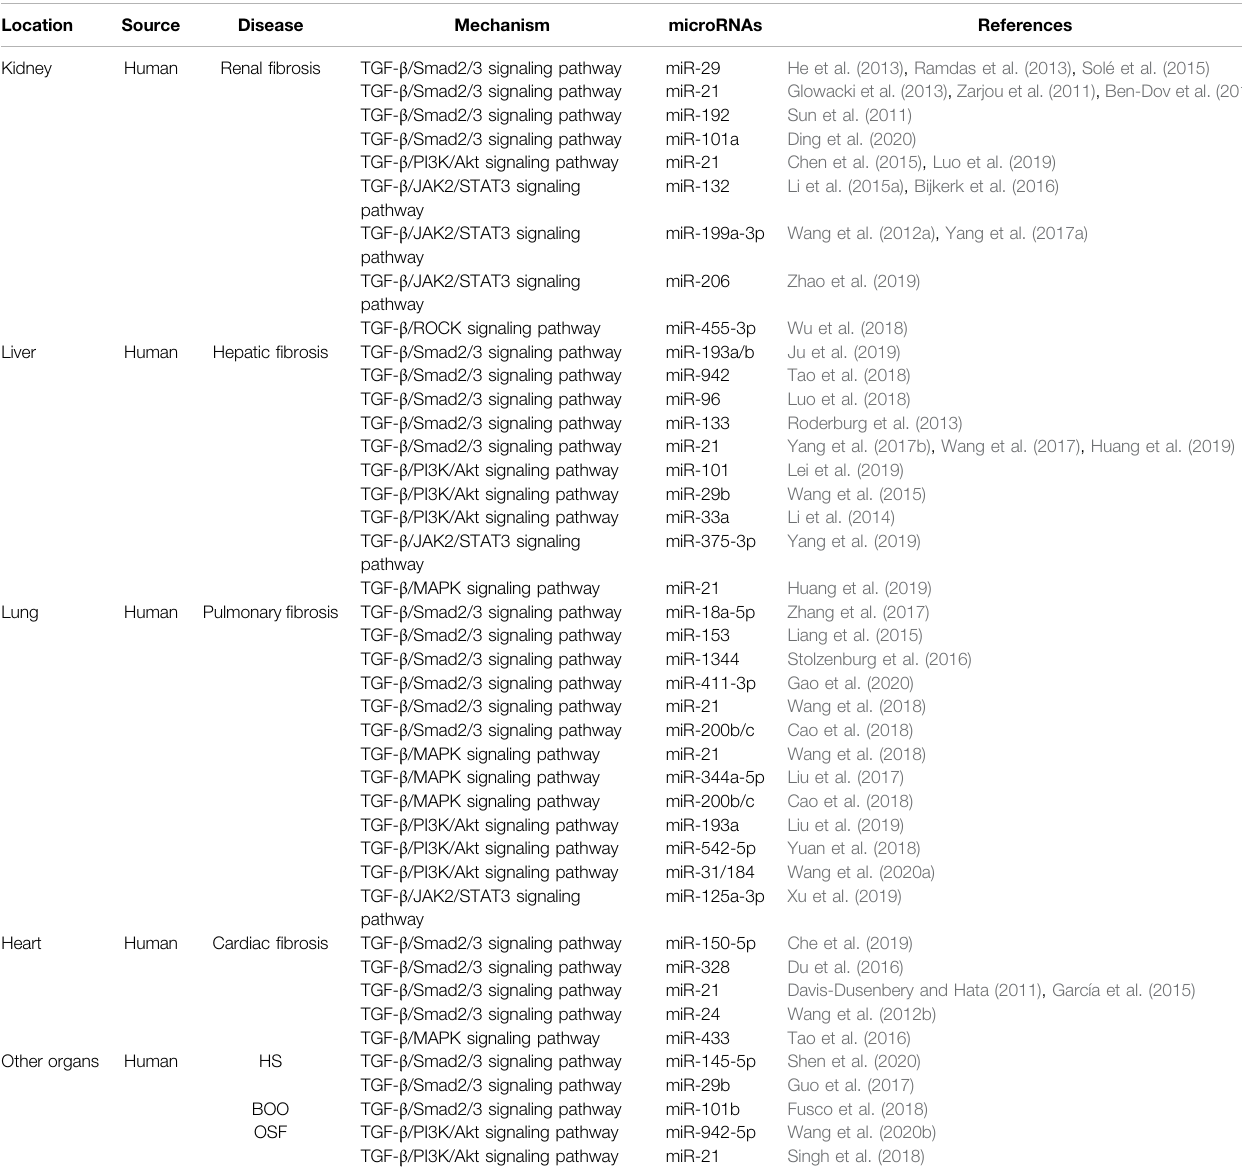
TABLE 1 | MiRNAs in canonical and noncanonicalTGF- β signaling in fi brotic diseases ofdifferent organs. HS, hypertrophic scar; BOO, bladder outlet obstruction;OSF, oral submucous fi brosis;TGF- β , transforminggrowth factor- β ;Smad2/3, drosophila mothers against decapentaplegic protein 2/3; PI3K, phosphatidylinositol 3-kinase; Akt, protein kinase B; MAPK, mitogen-activated protein kinase; JAK2, Janus kinase 2; STAT3, signal transducer and activator of transcription 3; ROCK, rho-associated coiled- coil containing kinase.